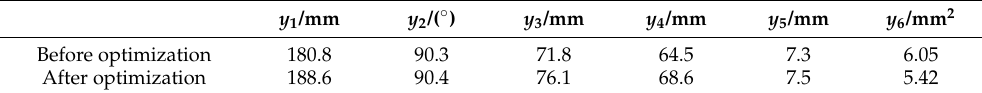
Table 8. Parameter comparison before and after optimization of mechanism parameters.